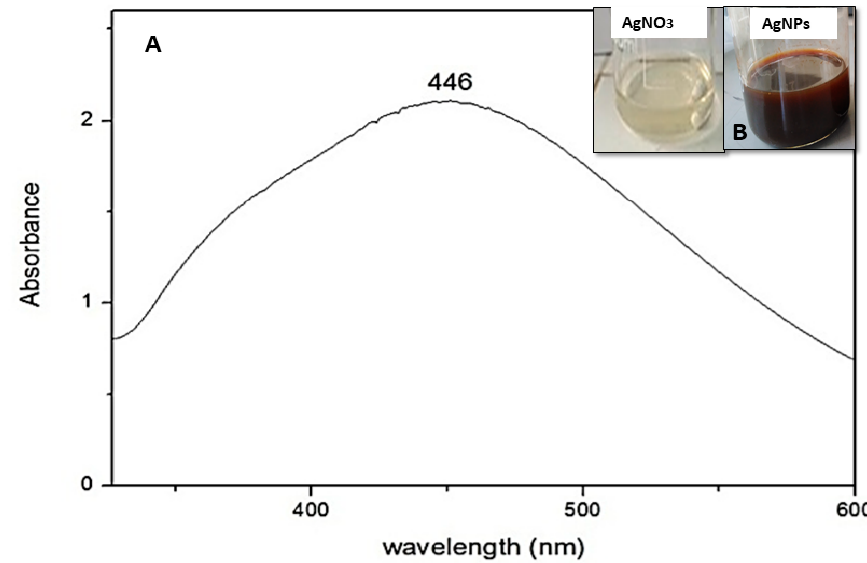
Figure 1. ( A ) Ultraviolet-visible absorption spectrum of silver nanoparticles and ( B ) Change of light brown color of AgNO 3 solution to dark brown color of AgNPs. Figure 1. (A) Ultraviolet-visible absorption spectrum of silver nanoparticles and (B) Change of light brown color of AgNO 3 solution to dark brown color of AgNPs.